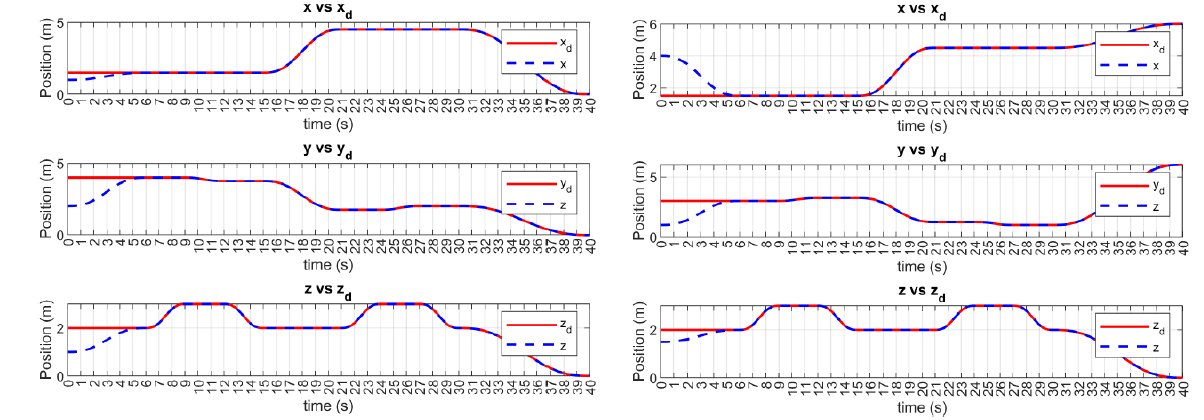
Figure 5. MFSOSMC 𝑥, 𝑦, and 𝑧 trajectory tracking (no external disturbances). BlueROV2 #1 ( left ).